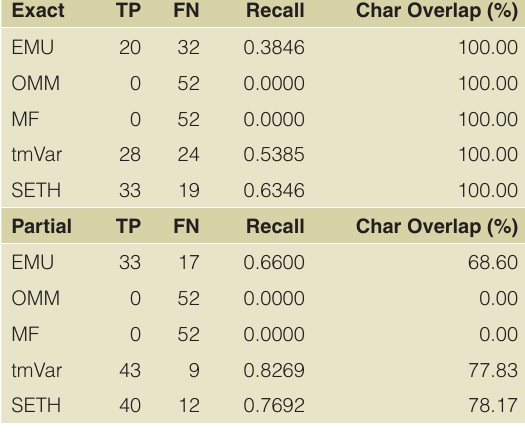
Table 4. DNA variant extraction recall result on the Variome corpus. Results for exact and partial matching are present. Each row shows the performance of each method in terms of true positives (TP), false negatives (FN) and Recall. The tools are Extractor of Mutations (EMU), OpenMutationMiner (OMM), MutationFinder (MF), tmVar and SNP Extraction Tool for Human Variations (SETH).